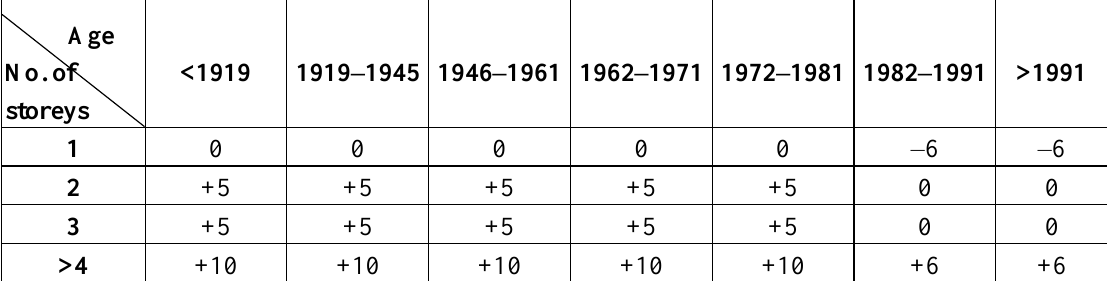
Table 2. Vulnerability index modifiers depending of number of storeys and construction age. Age No. of